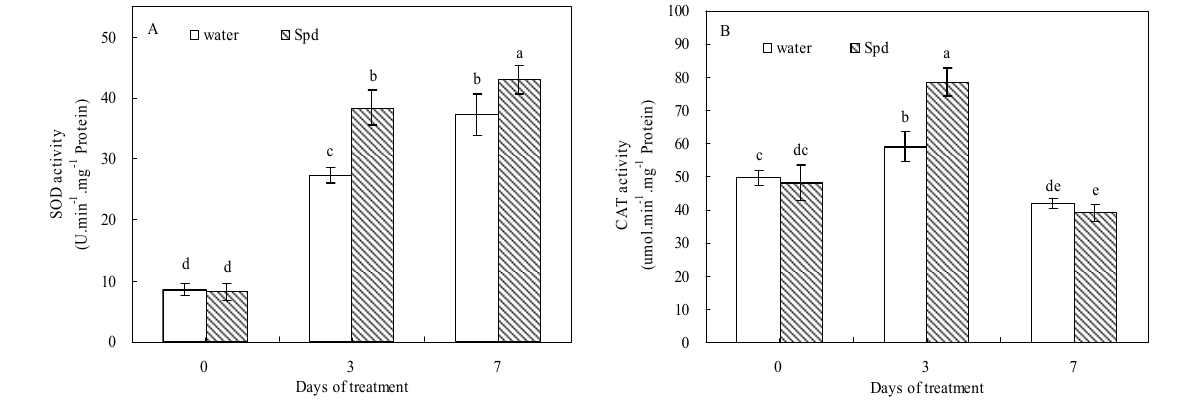
Figure 5. The effect of seed soaking with water or spermidine (Spd) on ( A ) superoxide dismutase (SOD) activity; ( B ) catalase (CAT) activity; ( C ) guaiacol peroxidase (POD) activity and ( D ) ascorbate peroxidase (APX) activity in the process of seeds germination (7 days) under water stress induced by 15% PEG. Vertical bars indicate ± SE of mean ( n = 6). Different letters above columns indicate significant difference. LSD ( p ≤